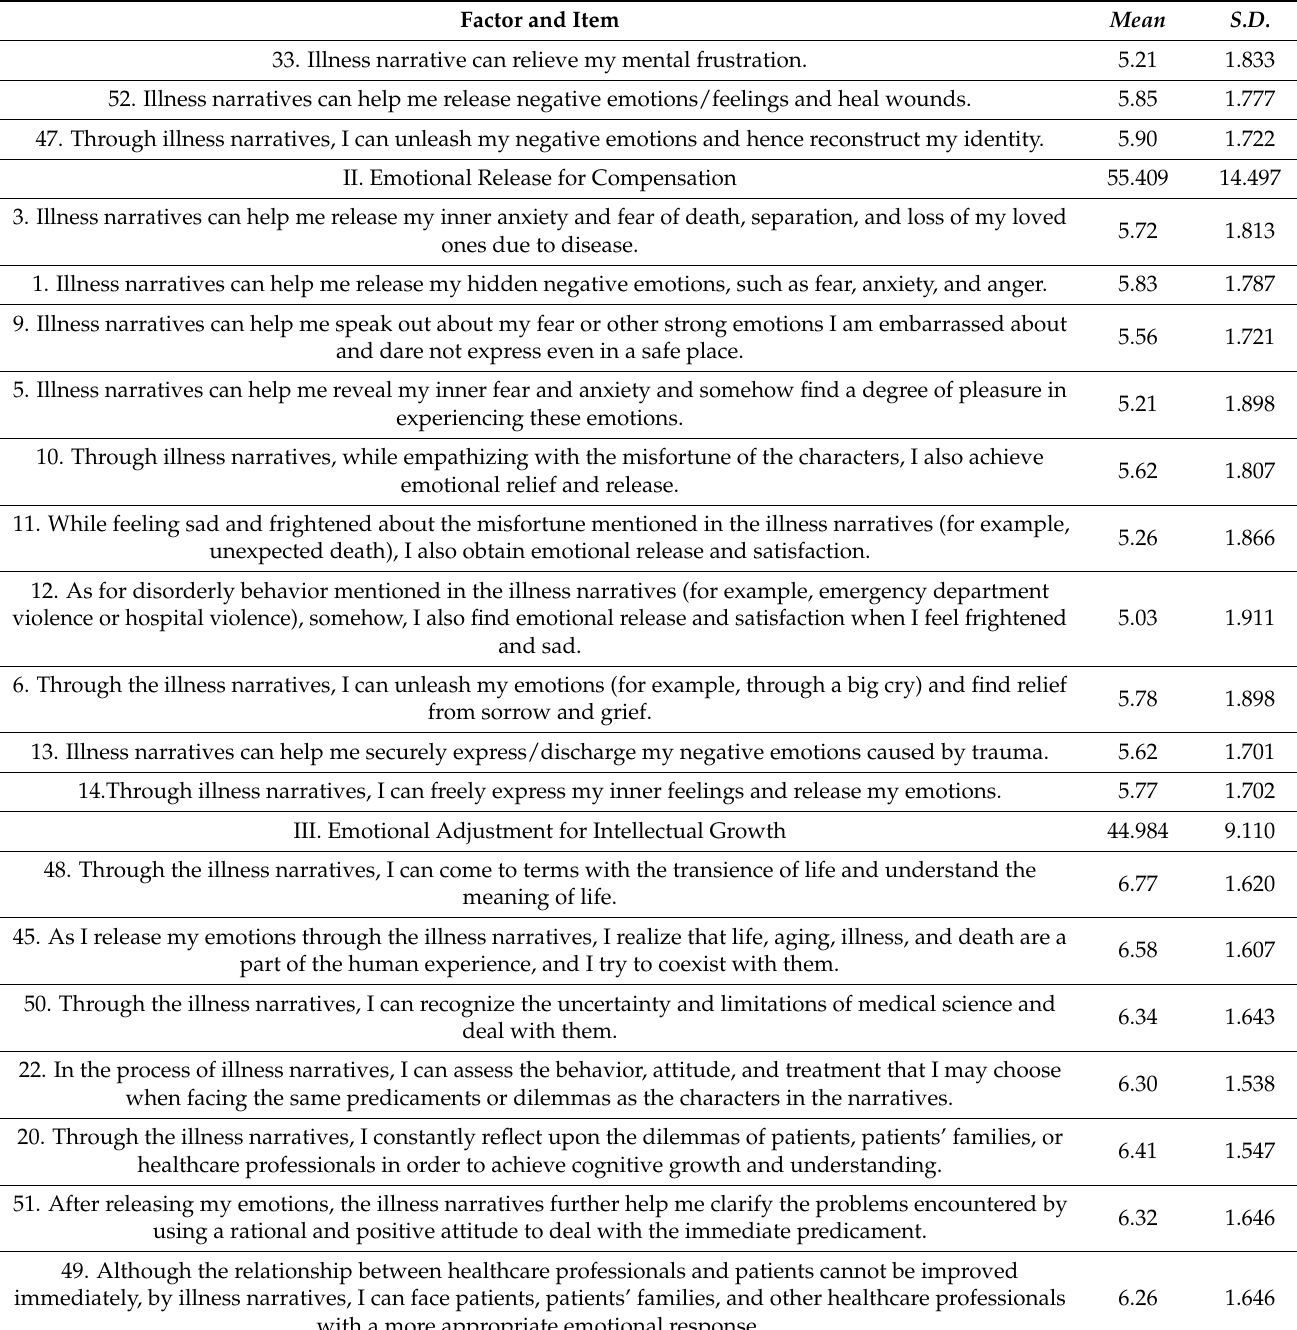
Table 2. Cont. Factor and